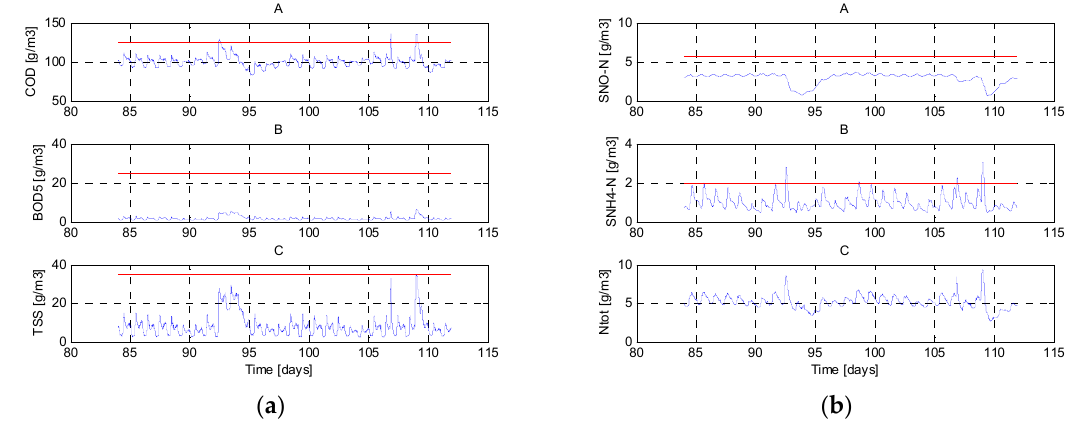
Figure 8. Loads of the effluent quality parameters: ( a ) COD , BOD 5 , TSS ; ( b ) SNO-N , SNH 4 -N , N tot .